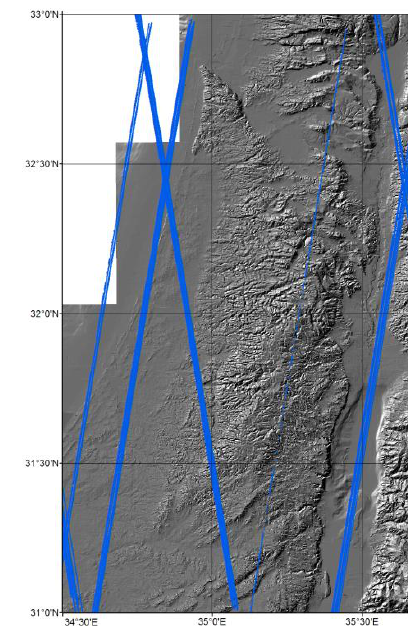
Figure 1. GLAS measurements overlaid on top of a shaded relief map of Israel (Hall, 1994) – 31º07'-32º57'N in latitude and 33º 58'-35º39'E in